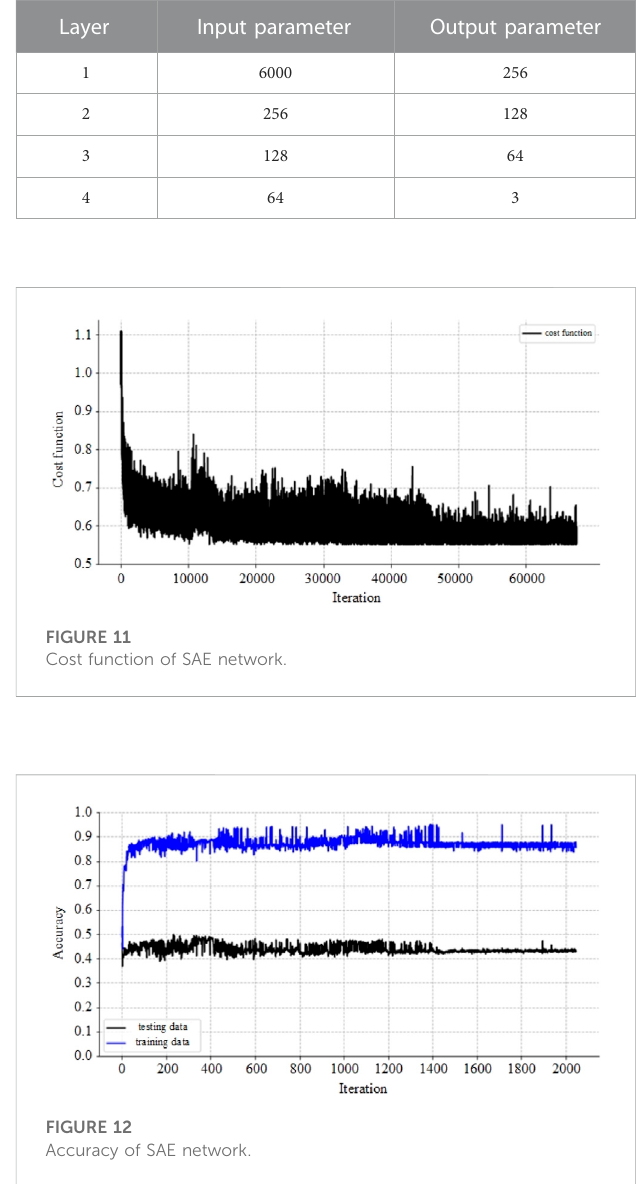
TABLE 3 SAE-dropout network parameters.